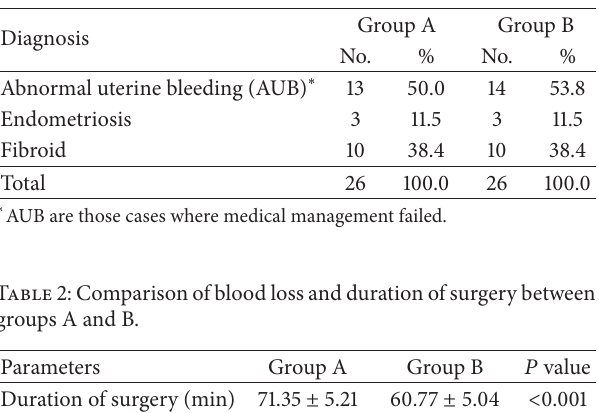
Group A Group B